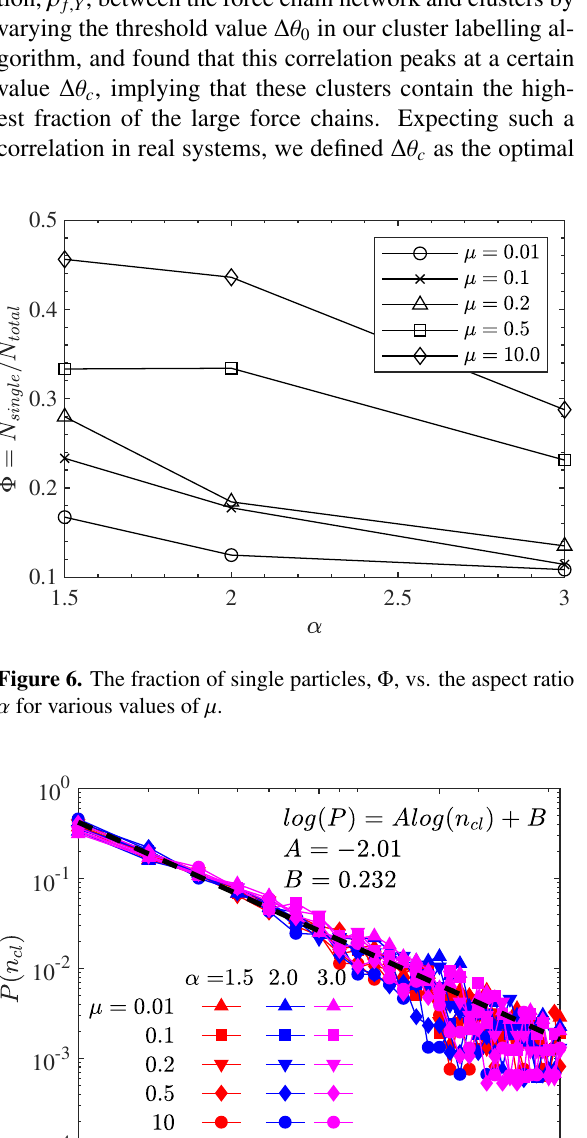
tom figure. The directions of the hatched lines represent